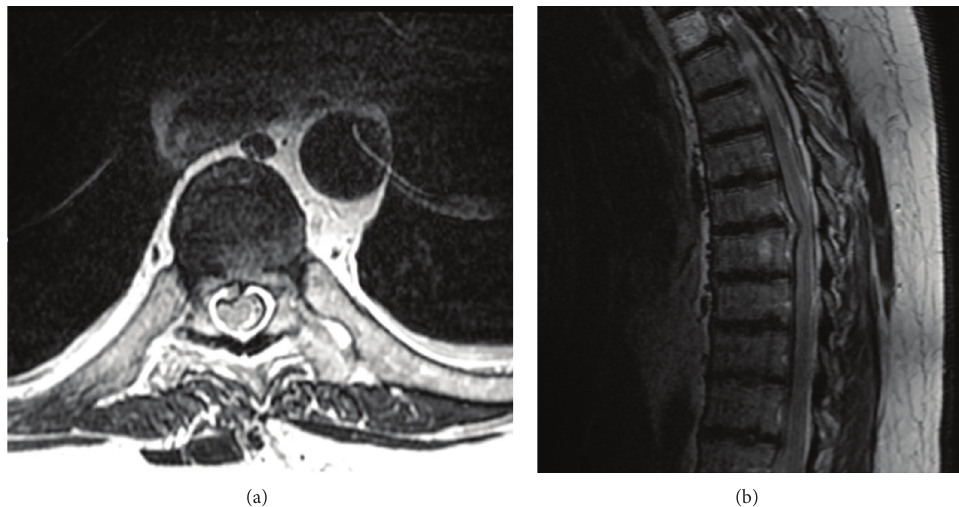
Figure 1: A thoracic spine T2-weighted axial (a) and sagittal (b). MRI reveals a right paramedian disc herniation at the T7-8 level with compression of the spinal cord. The disc appears to be soft and